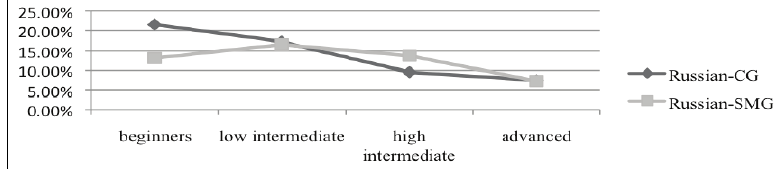
Figure 6: Self-evaluation of Greek of the participants and non-target test production